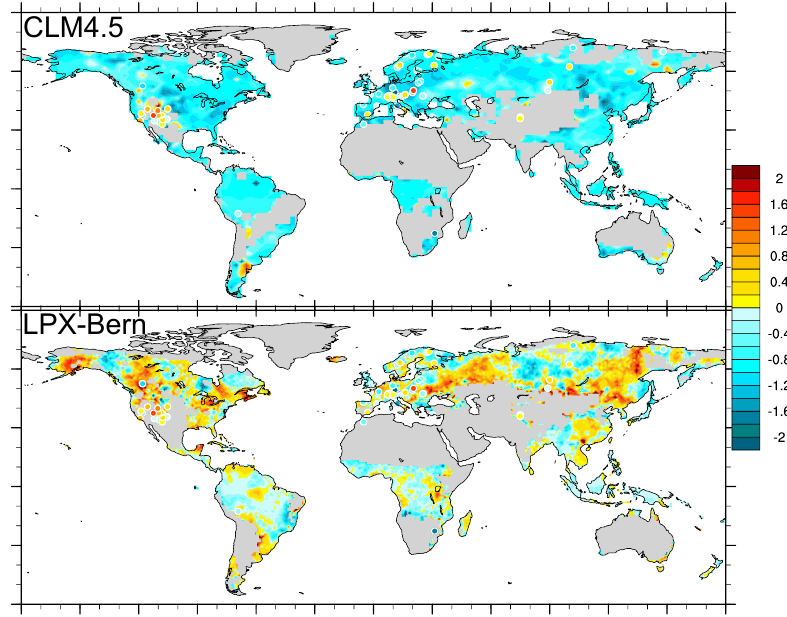
Figure 8. Century-scale change in the discrimination (cid:49) i of C3 trees. The discrimination is calculated from δ 13 C tree-ring data (colored circles) and (a) CLM4.5 and (b) LPX model results using Eq. (5). The changes are based on decadal means (1980s minus 1900s).